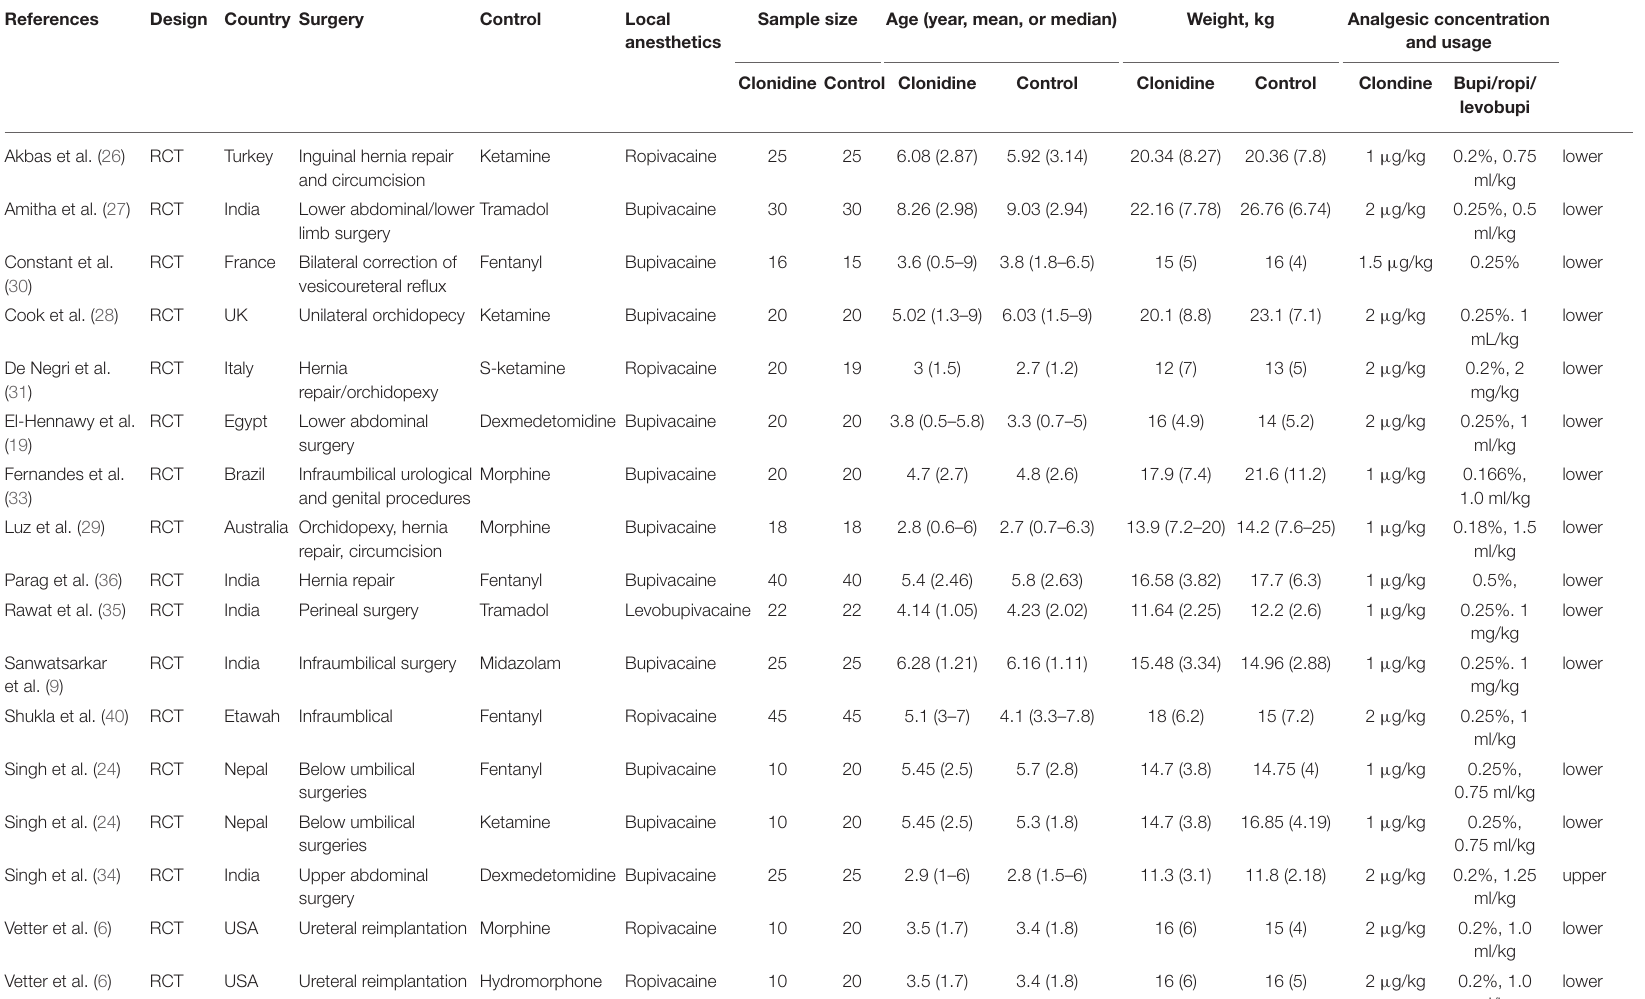
TABLE 1 | Literature search and characteristics of the included